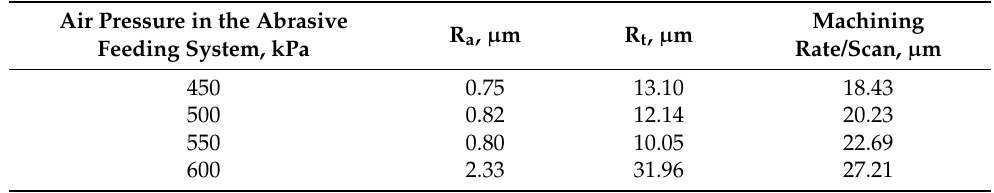
Table 1. LN thinning